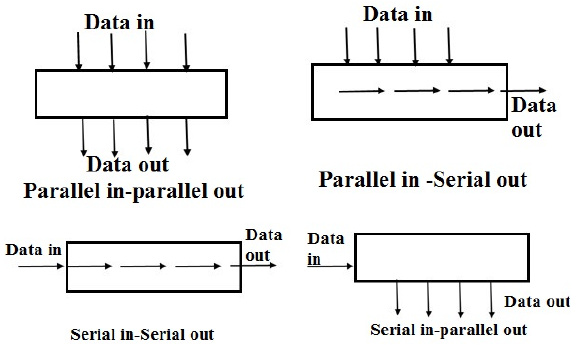
Figure 6. Basic data movement in shift registers. Adapted from [21], Medwell,